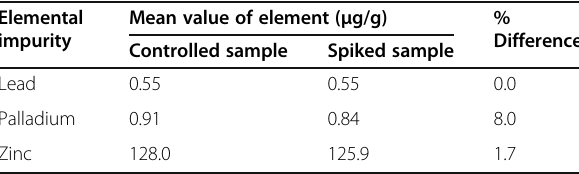
Table 1 Specificity